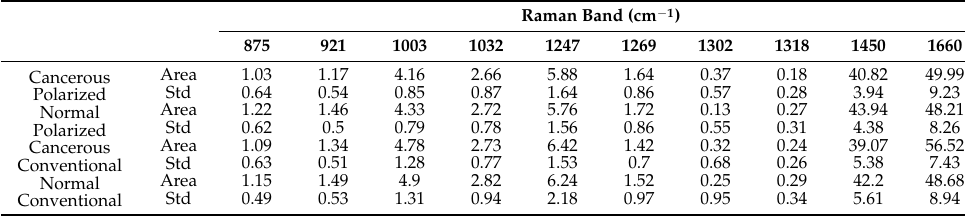
Table 3. Band area with standard deviation of each protein Raman peak.